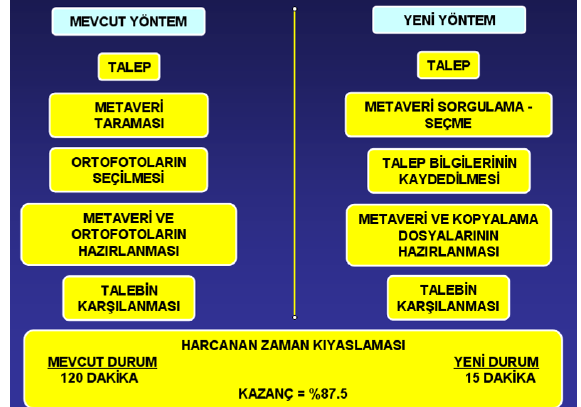
Figure 11. Time comparison of the metadata inquiry